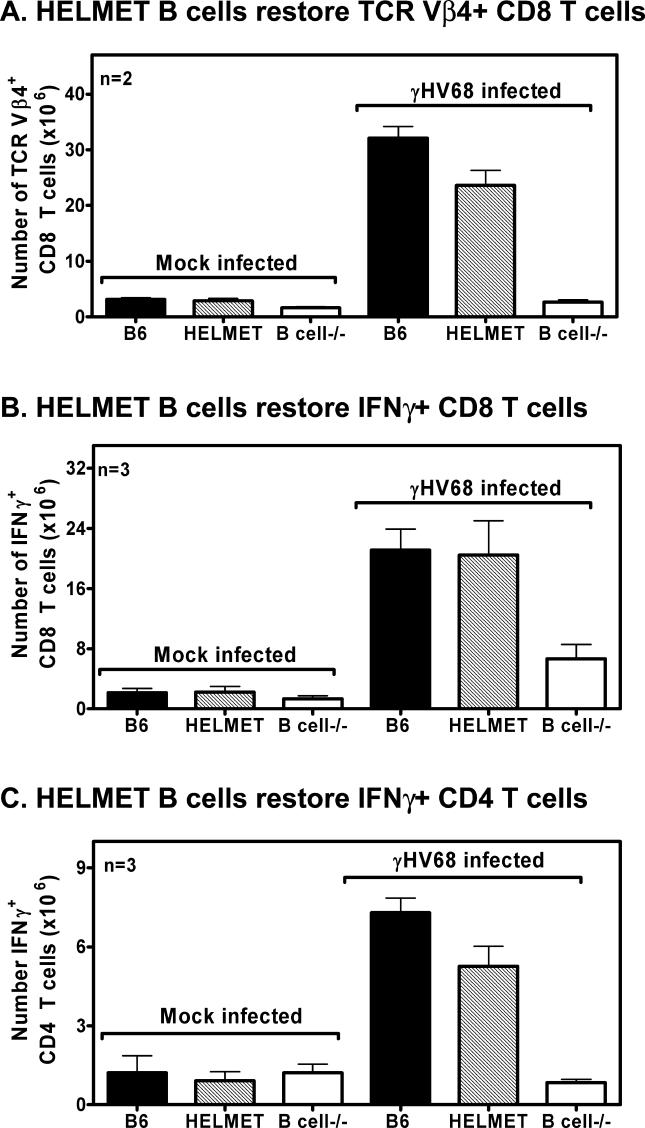
Virus Non-Specific B Cells Restore CD8 T Cell Defects Found in B Cell−/− MiceSplenocytes from mock infected and γHV68 infected B6, HELMET, and B cell−/− mice at day 21 (A) or day 16 (B and C) were counted and stained with antibodies specific for CD8 and TCR Vβ4 (A) or CD8, CD4, and IFNγ (B and C). Shown are the numbers of CD8 T cells/spleen that are TCR Vβ4+ (A) and the numbers of CD8 and CD4 T cells/spleen that produce IFNγ upon restimulation with PMA/ionomycin (B and C). These data were pooled from two to three independent experiments using three to five mice per experiment.